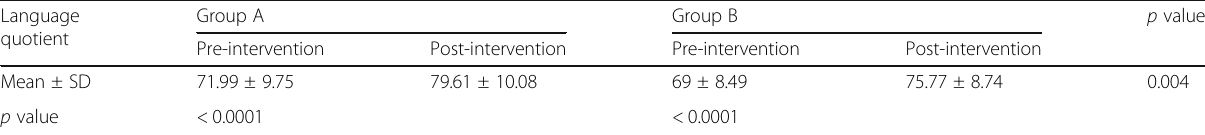
Table 4 Comparison of pre- and post-intervention language quotient in both groups Language Group A Group quotient